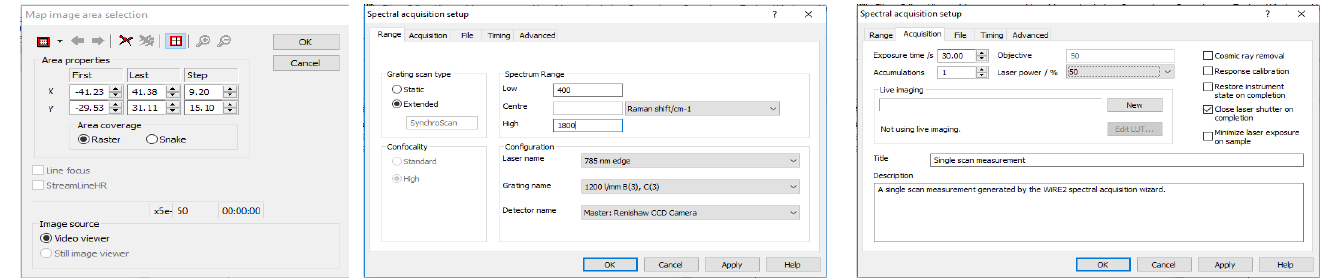
Figure 3. Spectral acquisition parameters for collecting spectra from the blood serum samples.